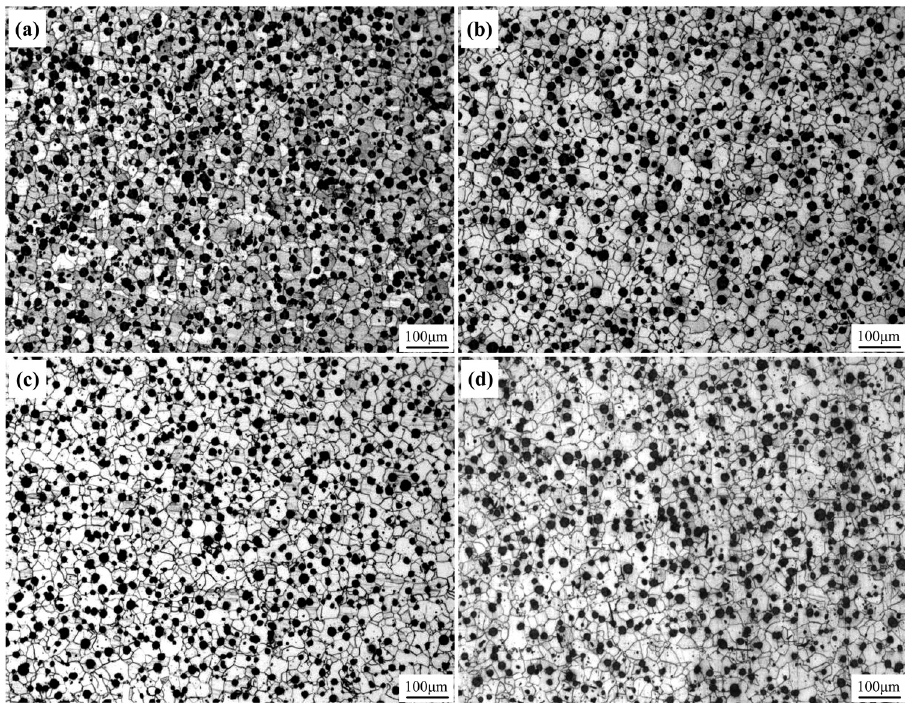
Figure 2: Metallographic structure ( a ) φ A = 15; ( b ) φ A = 20; ( c ) φ A = 25; and ( d ) φ A = 30.